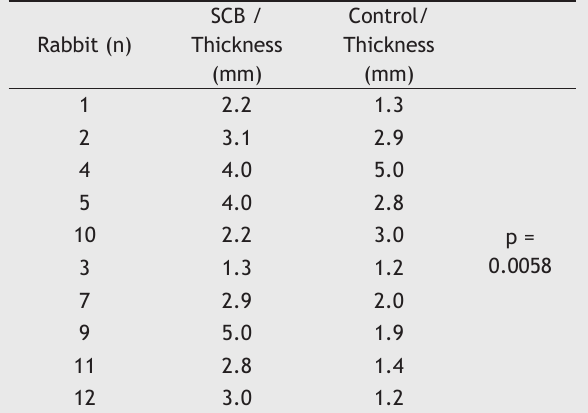
Table 5 Comparative analysis of thickness, measured at its greatest width in millimeters, of rabbit vocal folds injected with sugarcane biopolymer and control vocal folds.